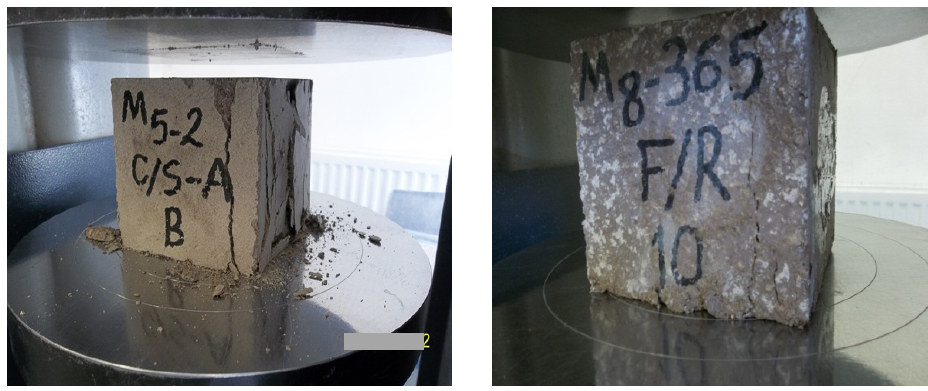
Figure 8. Failure mode of control ( left ) and 100% SPS ( right ) concretes.